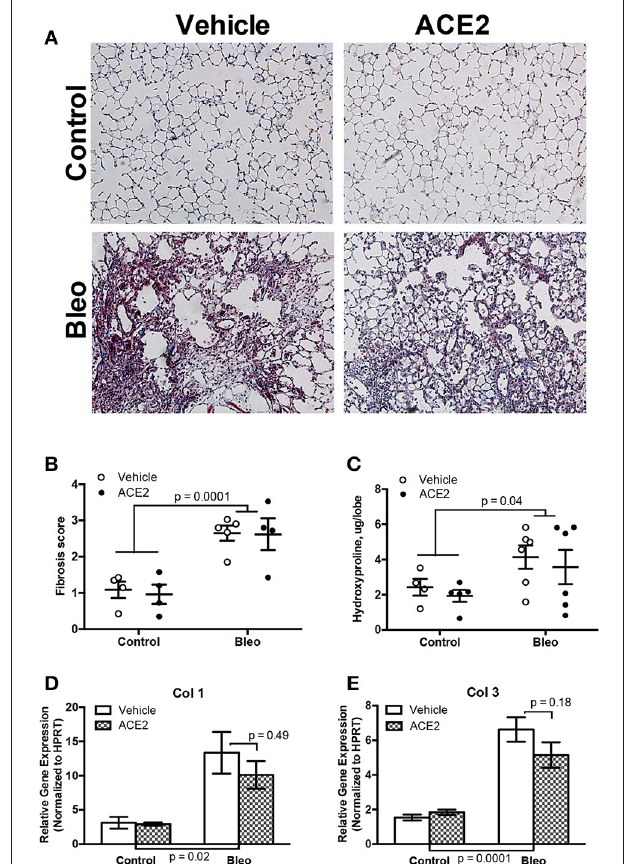
FIGURE 1 | Effect of rhACE2 treatment on bleomycin-induced pulmonary fibrosis. Lung sections were stained with Masson’s trichrome, visualized at 10X (A) and scored for parenchymal remodeling and fibrosis (B) . Lung collagen was estimated from tissue by hydroxyproline assay (C) , and expression of collagens Col1 (D) and Col3 (E) were estimated by RT-PCR. Data presented in (D,E) are ± SEM mean, n = 4, 5, 6, and 6 for the control, ACE2, Bleo and Bleo + ACE2 groups respectively. P -values are the result of two-way ANOVA followed by Holm-Sidak’s multiple comparison post-test; in each case, bleomycin groups were significantly different from control, and ACE2-treated not significantly from